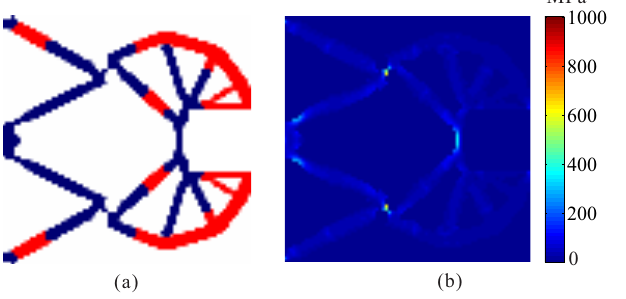
Figure 7. The results for topological design of multi-material compliant gripper without stress constraints. ( a ) Optimal topology; ( b ) stress distribution. constraints. ( a ) Optimal topology; ( b ) stress